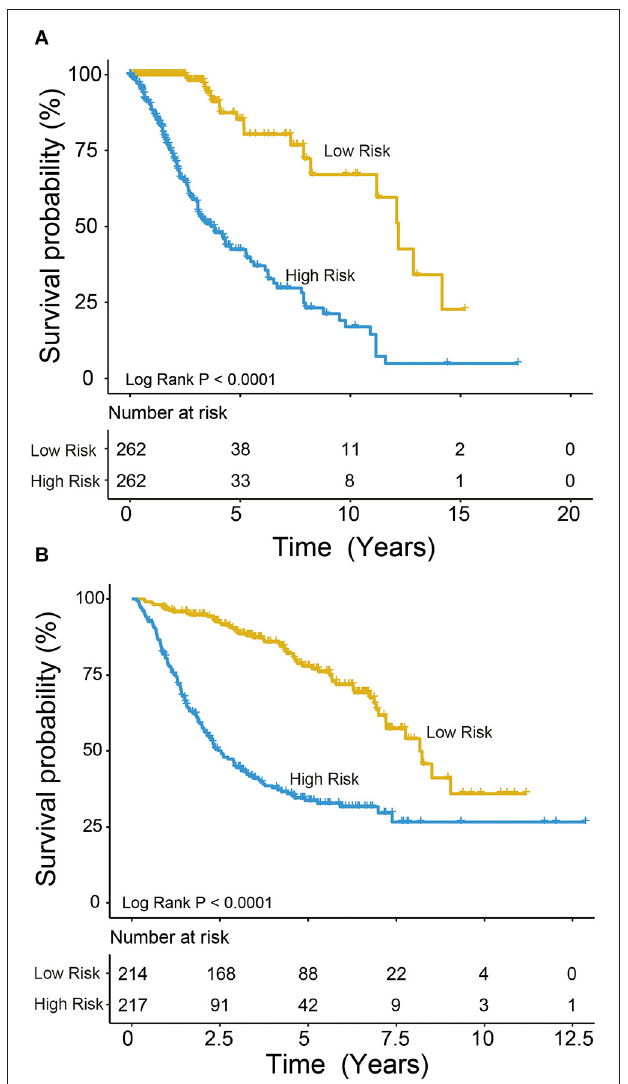
FIGURE 2 | Kaplan–Meier plots indicated that LGG patients could be classified into high- and low-risk groups according to the five-gene signature in the training (A) and test (B)